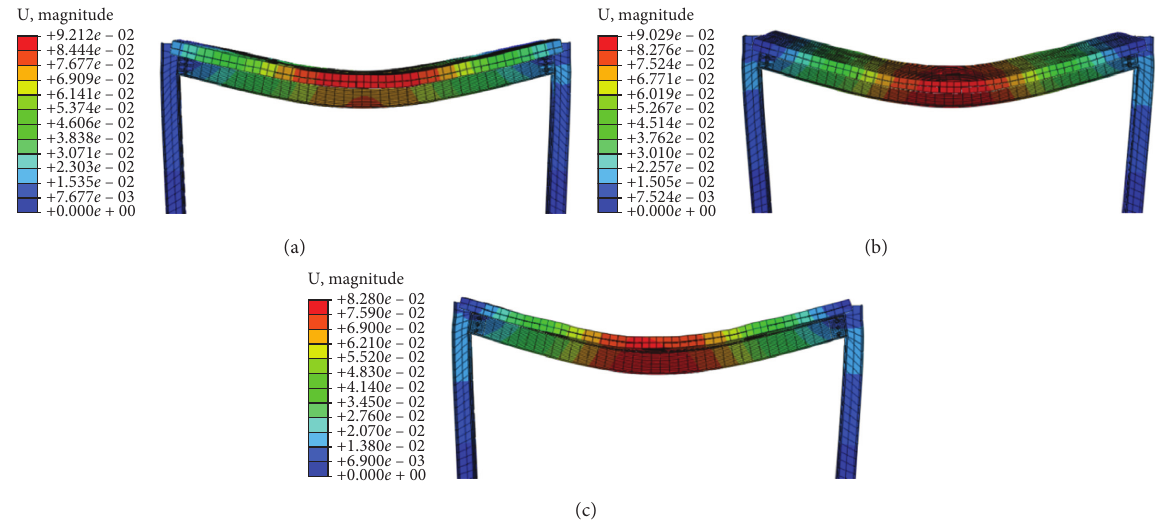
Figure 15: Displacement contours of three tested specimens: (a) SCB-1, (b) SCB-2, and SCB-3 (units are in